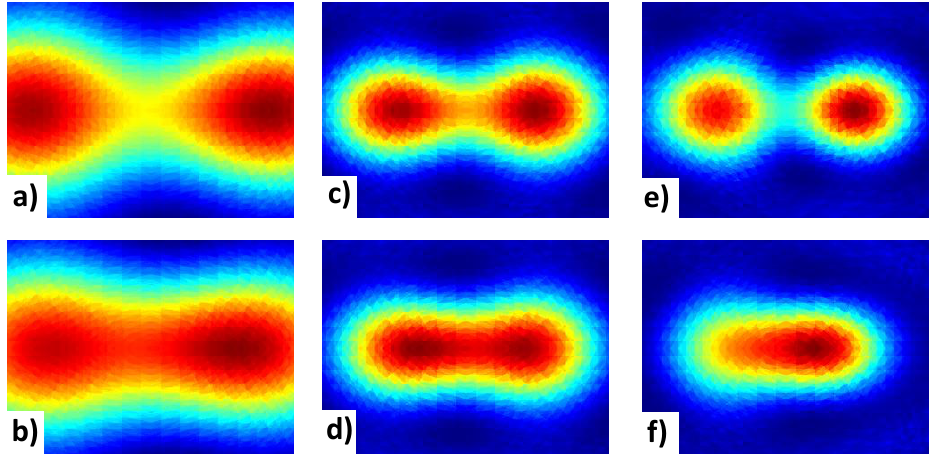
Figure 7. Acoustic heatmaps generated by an emulator to test the spatial resolution of the microphone array. Two sound sources are placed one meter from the array and moved towards each other to find the minimum distance between required between the sound sources to identify both sound sources. By increasing the frequency of either of the two sound sources, the minimum distance required to distinguish both sound sources from each other is decreases. Acoustic heatmaps: ( a , b ) two sound sources of 4.5 kHz and 5 kHz placed at ( a ) 62 ◦ and ( b ) 66 ◦ . ( c , d ) two sound sources of 8 kHz and 7.5 kHz placed at ( c ) 74 ◦ and ( d ) 78 ◦ . ( e , f ) two sound sources of 8 kHz and 9.5 kHz placed at ( e ) 74 ◦ and ( f ) 80 ◦ . 90 ◦ corresponds to the center of the